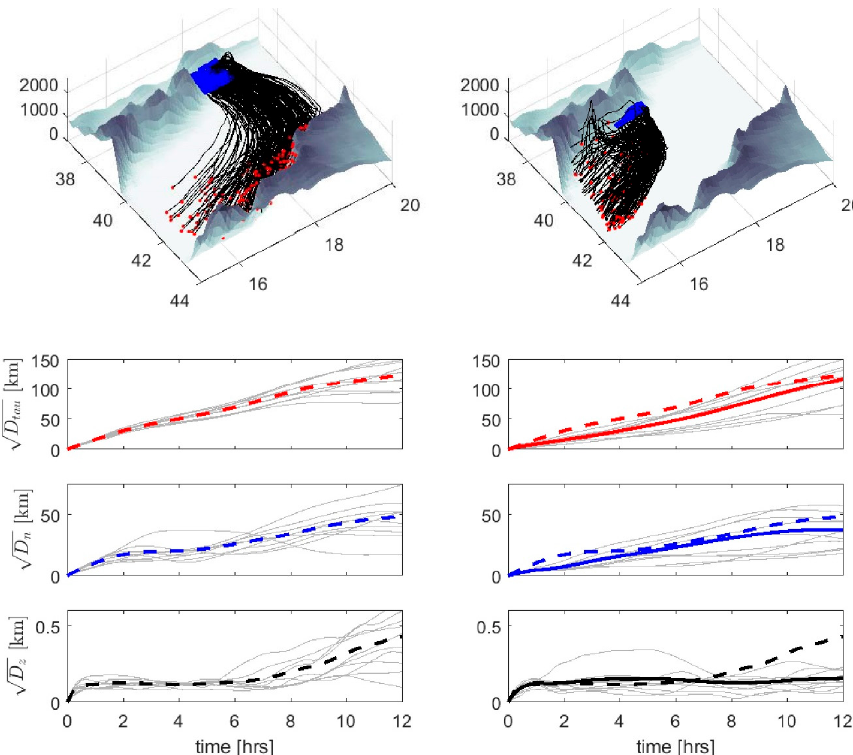
Figure 17. Single-particle dispersion ( D ) in the horizontal ( D τ , D n ) and vertical ( D z ) direction calculated for groups of trajectories initiated at the exits of the Tokar Gap (left) and Gap 2 (right). Twenty-five trajectories were released every hour from 00 UTC to 09 UTC on 07/12/2008. Dispersion curves for the individual releases are shown in grey, and means are shown by thick colored curves, dashed for the Tokar Gap and solid for Gap 2. Dashed curves are superimposed in the right panels for comparison purposes. In each case, the trajectories were initiated at z = 500 m, and where the horizontal wind speed exceeds 10 m s − 1 .